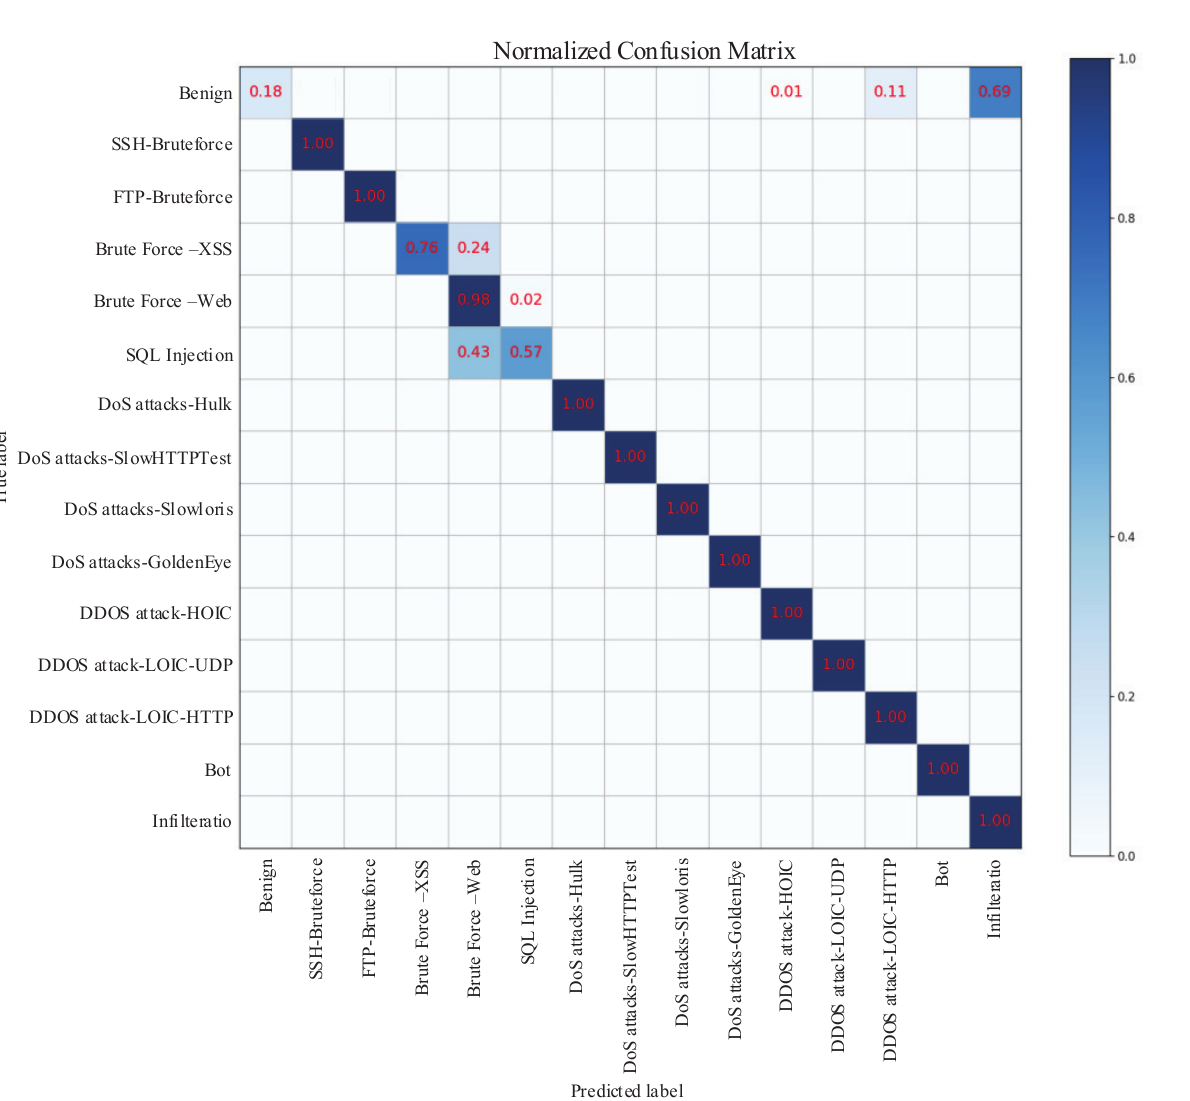
Figure 2. Normalized confusion matrix when training CNN with the original training set in